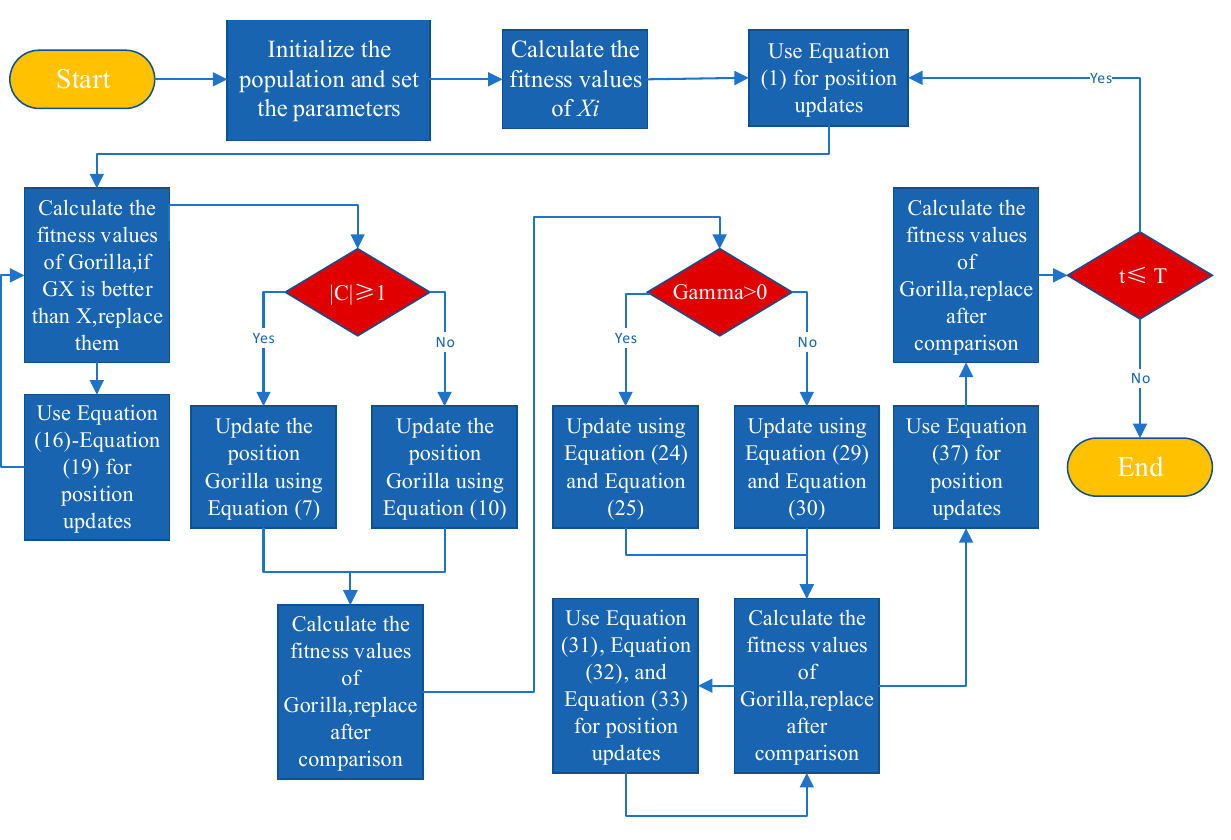
Figure 1. Flowchart for proposed MGTO algorithm.